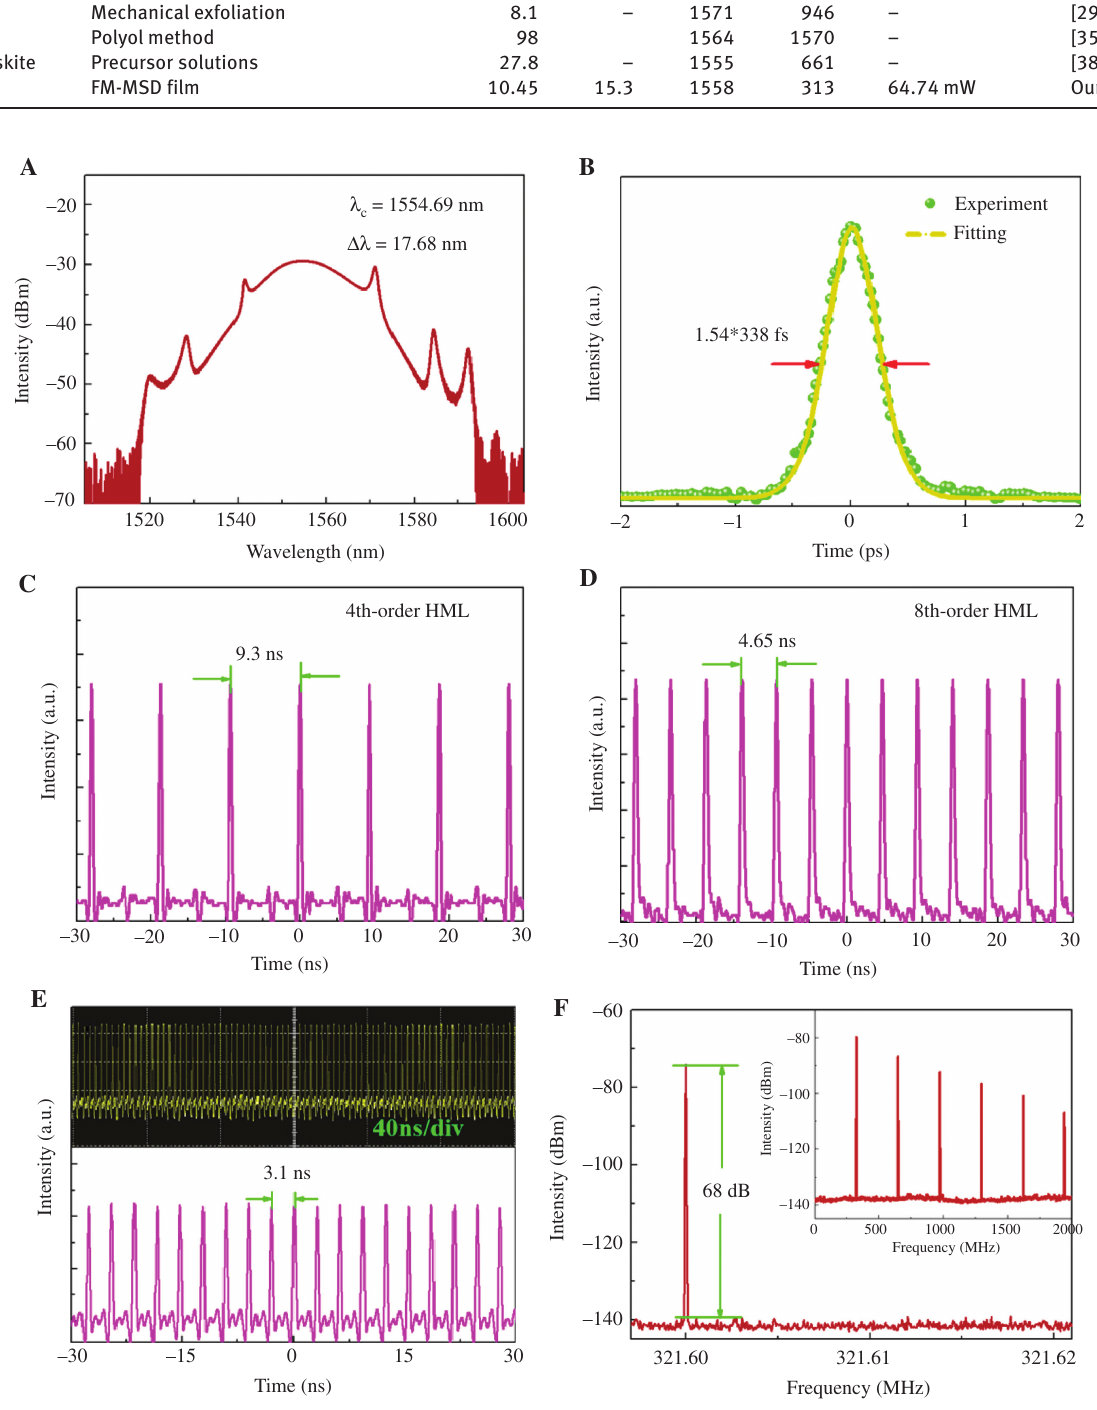
Figure 5: Typical mode-locking pulse output characteristics. (A) Optical spectra. (B) Autocorrelation traces. (C–E) Oscilloscope trace of the 4th HML, 8th HML, and 12th HML. (F) RF spectra.